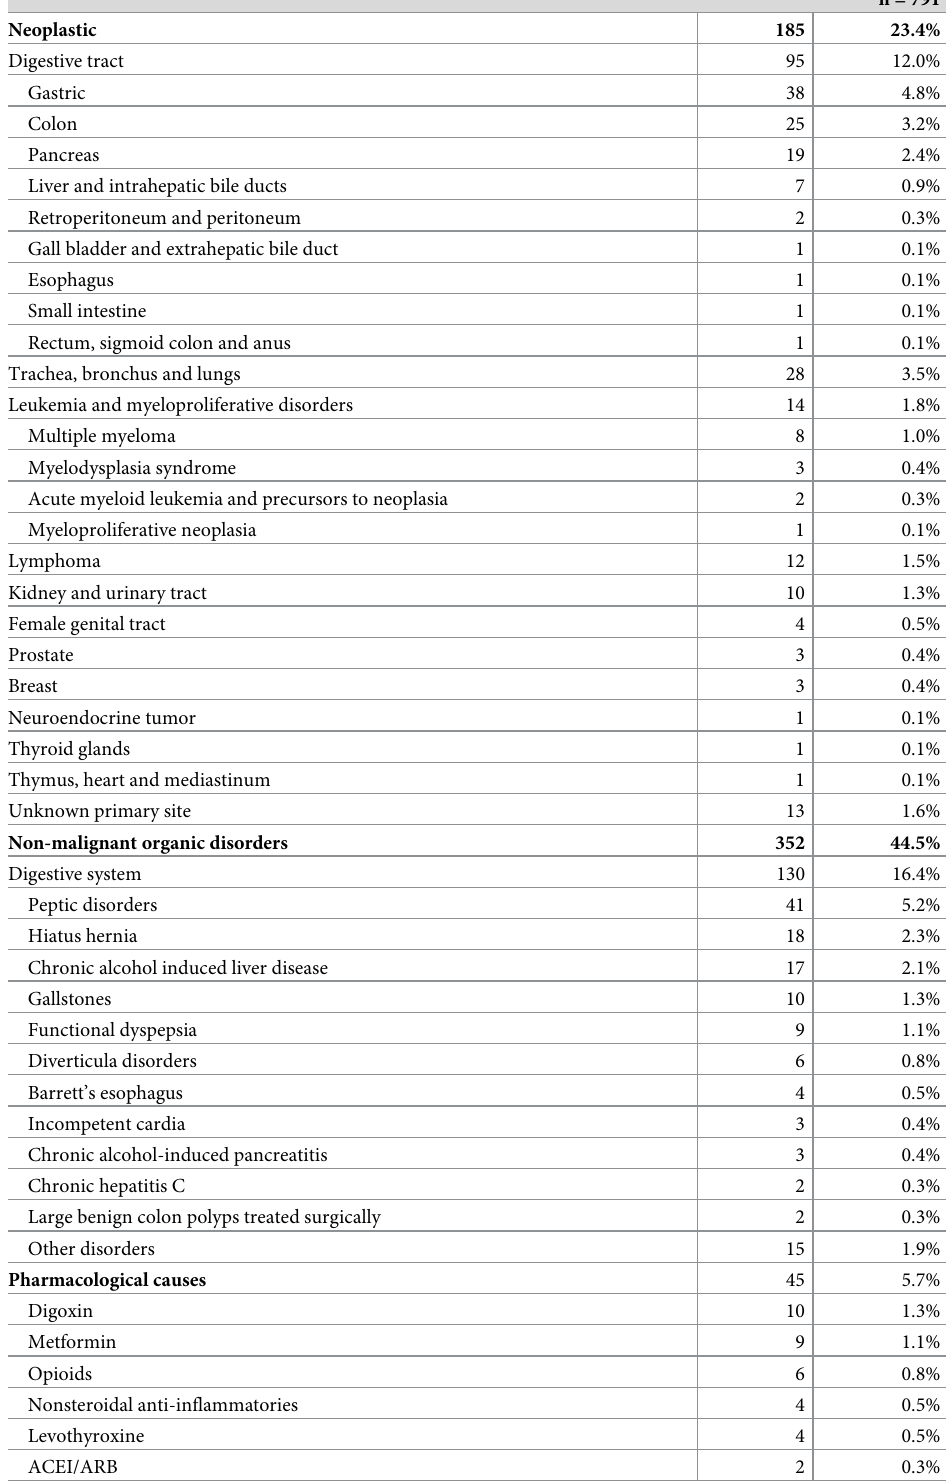
Table 4. Causes of